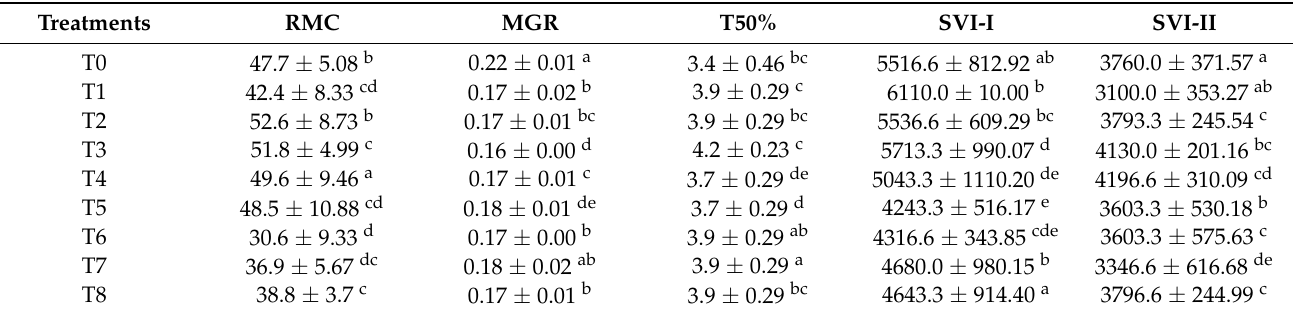
Table 3. Effect of AsA and/or α -toc on A. sativa RMC, MGR, T50%, SVI-I, and SVI-II under drought